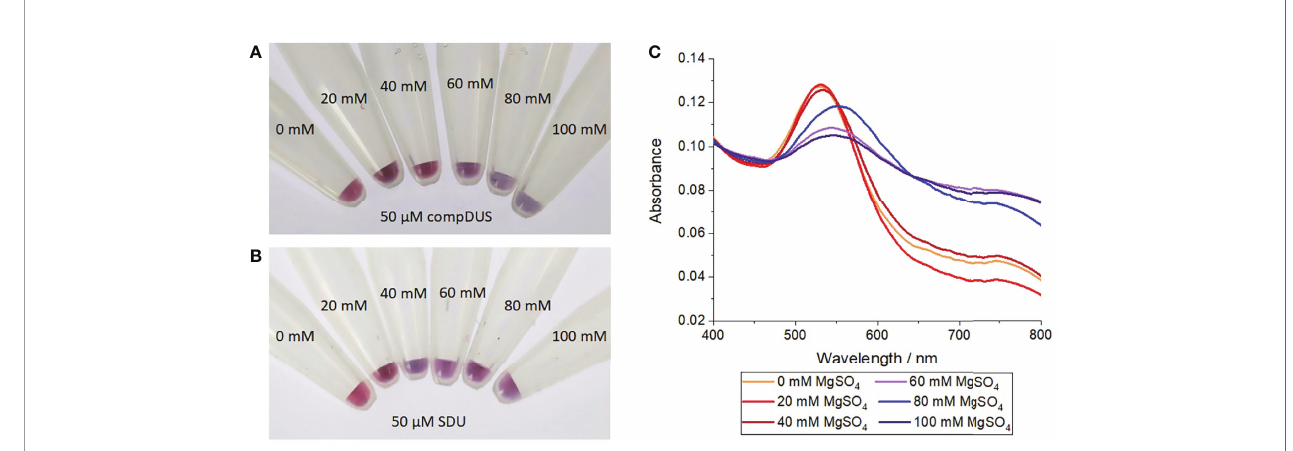
FIGURE 2 | Salt-induced aggregation test of gold nanoprobes treated with complementary or control oligonucleotides. (A) Photograph of nanoprobes after incubation with 50 µM of a reverse complement DUS (compDUS), heating to 95°C, before cooling to room temperature and treating with different concentrations of MgSO4, (B) Photograph of nanoprobes after treatment as before but with 50 µM of random scramble oligonucleotide (SDU) in place of compDUS, (C) UV-vis absorption spectra of nanoprobe samples treated with compDUS at increasing concentrations of MgSO 4 . Each experiment was repeated 3 times, with photographs shown from 1 repeat.